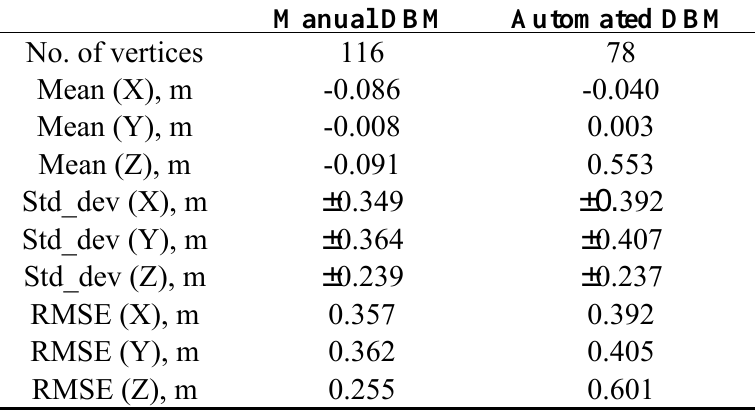
Table 2. Statistics derived from the comparison of two manually generated sets of DBM vertices (second column) as well as the comparison of automatically and manually generated DBM vertices (third column).